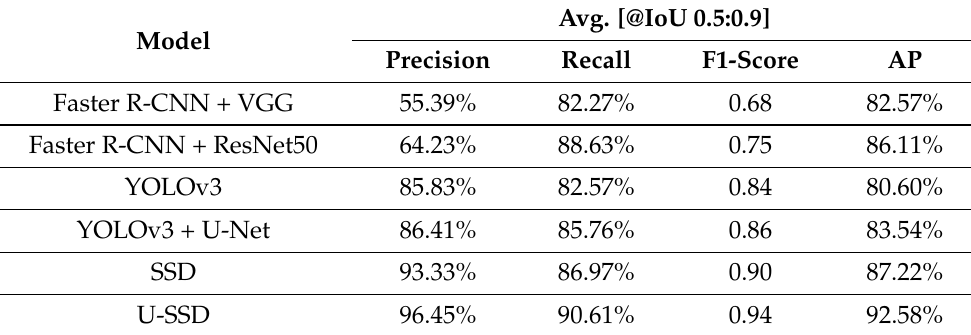
Table 4. The comparison from IoU = 0.5 to 0.9 on our